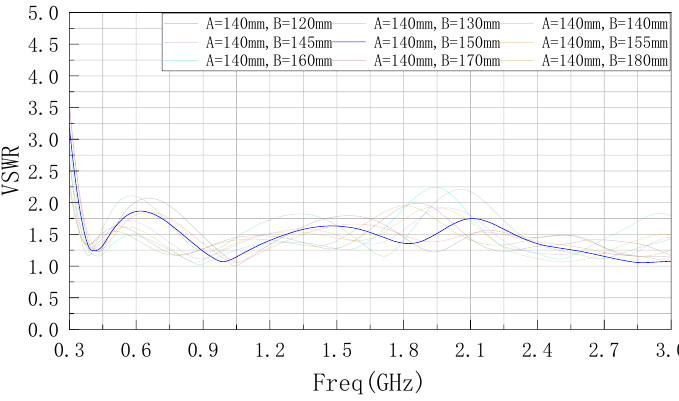
Figure 5. VSWR curve after optimized parameter B.